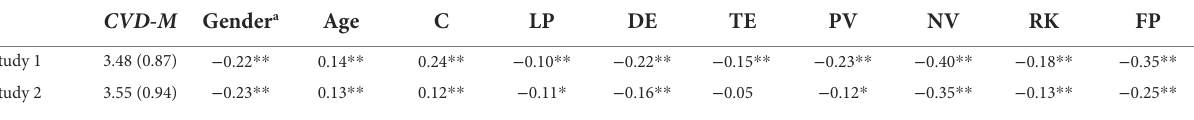
TABLE 6 Adherence to COVID-19 guidelines over-time: comparison across studies: Means, SDs, and Pearson’s r correlation with the other variables measured in Study 1 and Study 2.